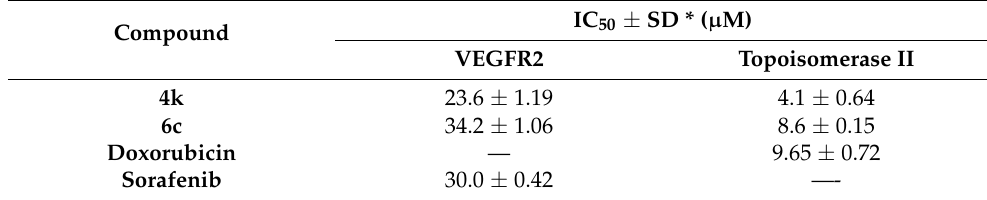
Table 3. Inhibitory activities of the hit compounds towards topoisomerase II, VEGFR2 target enzymes.